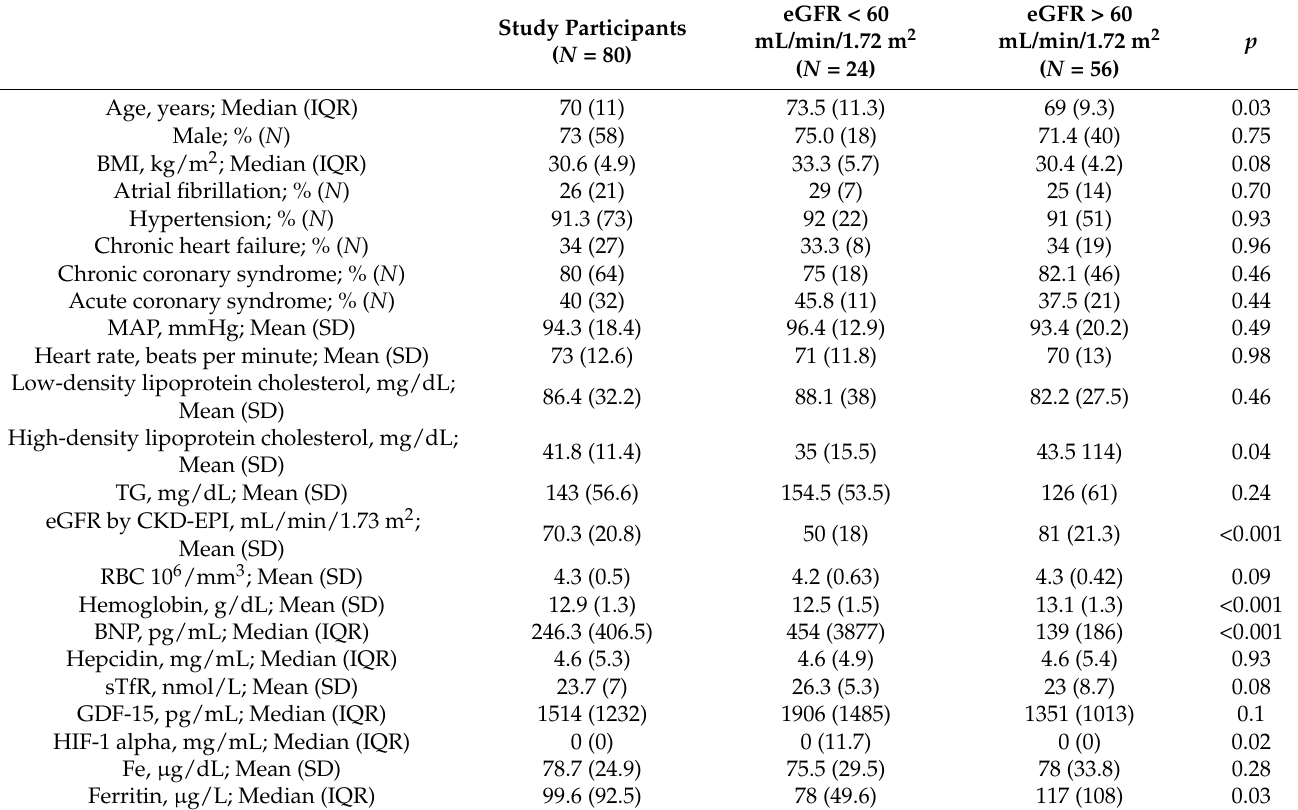
Table 2. Comparisons between patients with and without chronic kidney